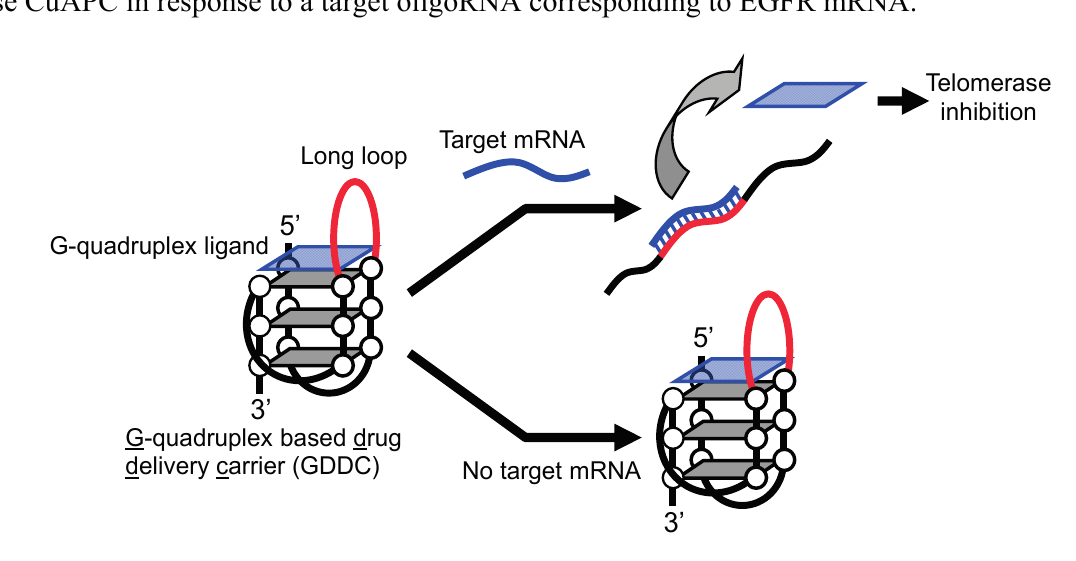
Figure 1. Principle behind DDS using a GDDC for cancer therapy. In the absence of a target mRNA in normal cells, the GDDC retains its G-quadruplex structure and thus a G-quadruplex ligand (a telomerase inhibitor) remains bound. In the presence of the target mRNA in cancer cells, the G-quadruplex structure of the GDDC unfolds, releasing the G-quadruplex ligand and inhibiting telomerase